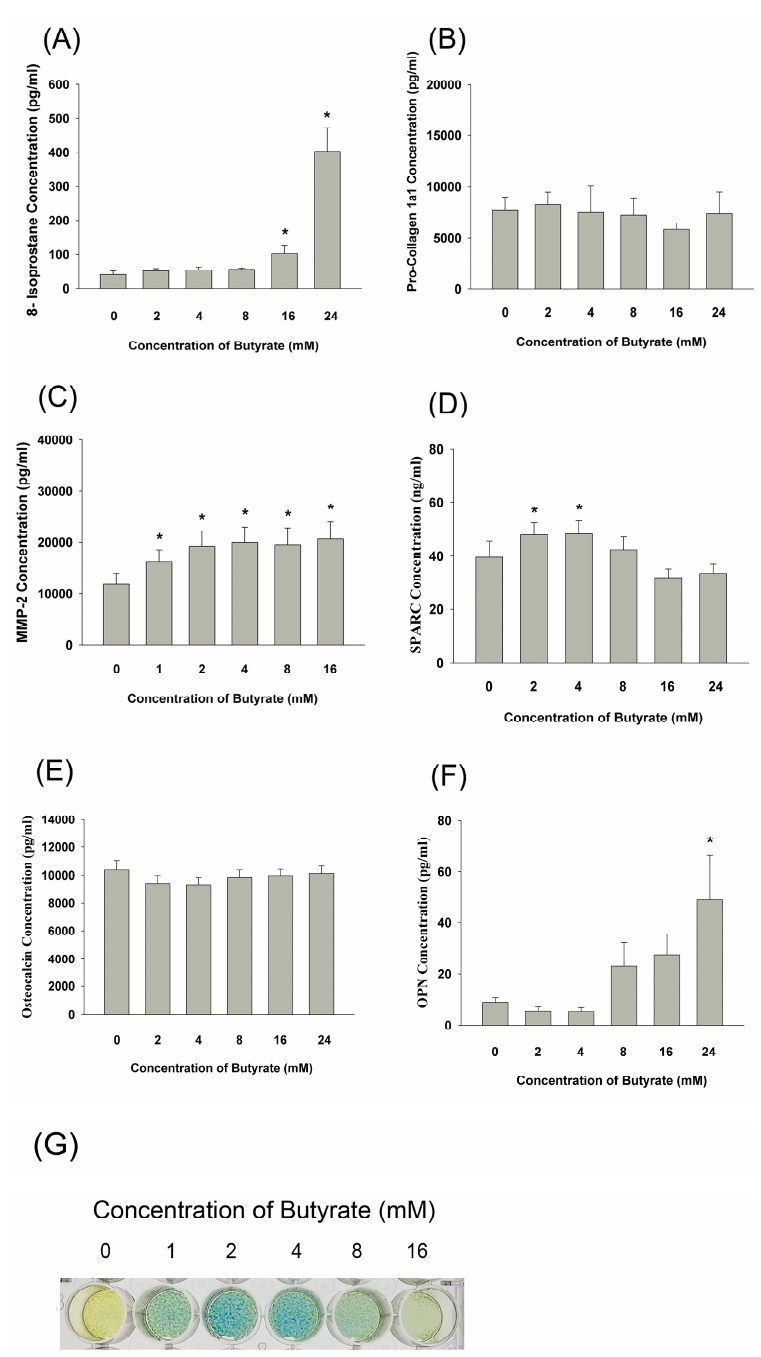
Figure 7. Effect of three days of exposure to butyrate on ( A ) 8-isoprostane, ( B ) pro-collagen I, ( C ) MMP-2, ( D ) osteonectin, ( E ) osteocalcin, and ( F ) osteopontin (OPN) secretion of MG-63 cells as analyzed by ELISA. Results were expressed as mean ± SE. Statistically significant differences are denoted by * when compared with the control ( p < 0.05). ( G ) Effect of butyrate on the alkaline phosphatase (ALP) activity of MG-63 cells. One representative ALP staining picture was shown.